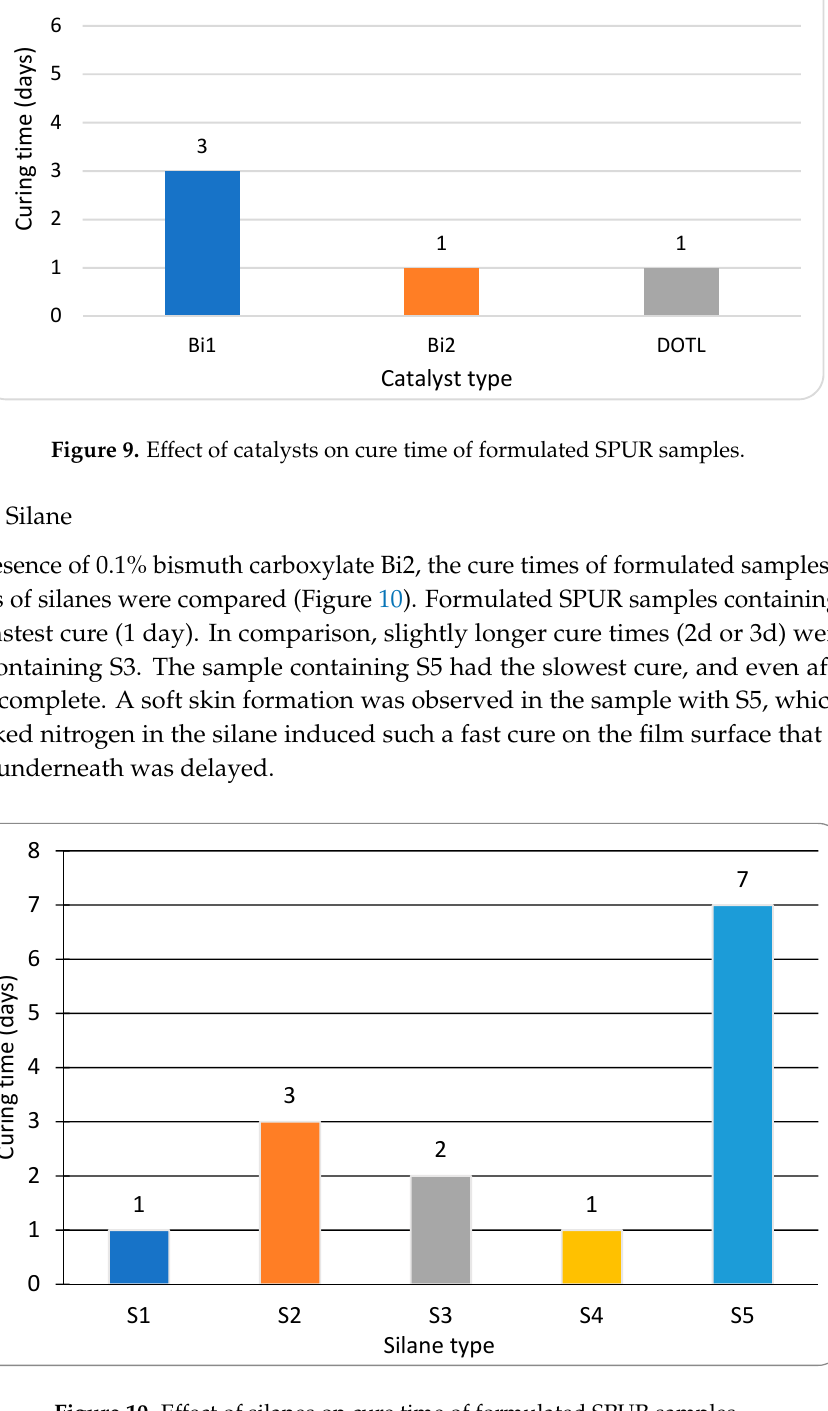
Table 8. The mechanical test results of cured SPUR with different PPG chain length.